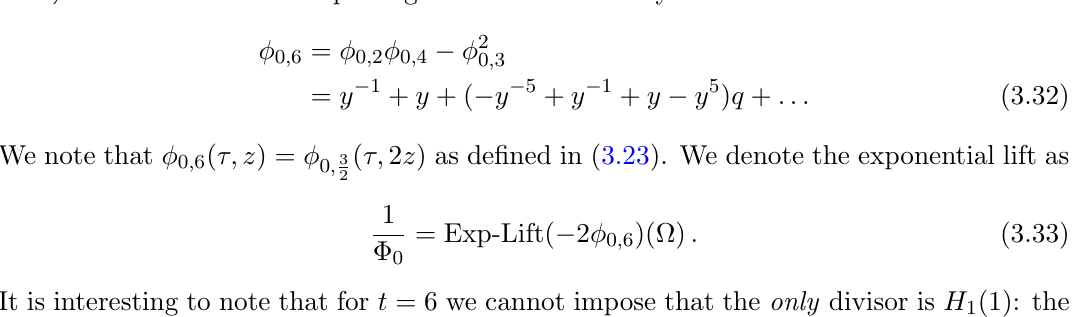
Table 1 . The (cid:12)ve exponential lifts whose only divisor is H 1 (1), and integral weight that is non- negative. The coe(cid:14)cients A; B; C and k are those de(cid:12)ne in (2.21) and (2.22). t=6,